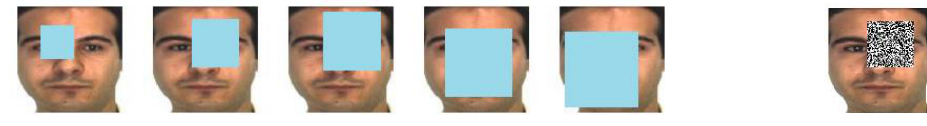
Figure 3. Color face sample of AR dataset and self-added occlusion processing example.